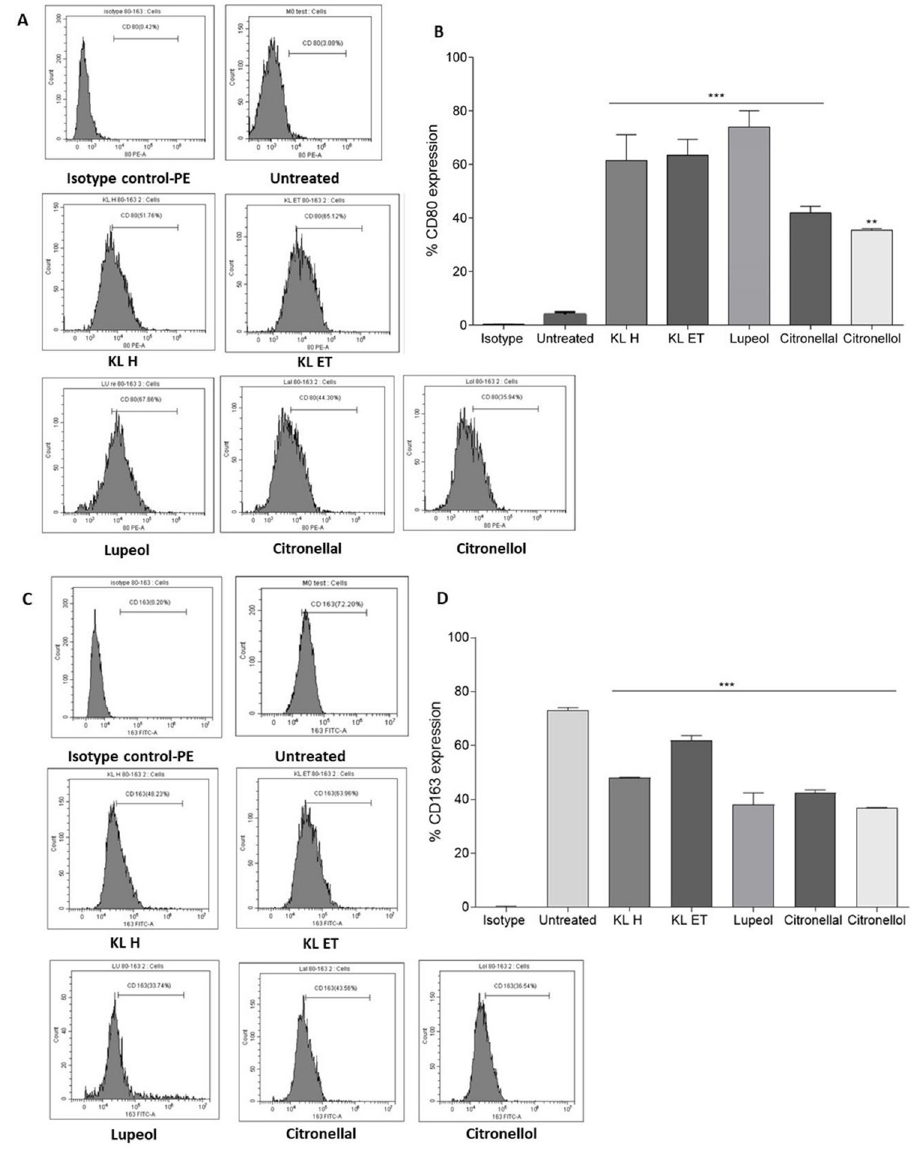
Fig 8. Characterization of the phenotype of THP-1 derived macrophages after treatment with crude KL extracts and their compounds. (A) and (B) Flow cytometry analyses of M1-typical surface markers representing the percentage of CD80 positive cells. (C) and (D) Expression of CD163 and M2 positive cells. Bar graphs are shown as means ± SEM., ��� p � 0.001, compared to the control. compound-mediated apoptosis in SCC15 significantly increased the level of pro-apoptotic (Bax) and cleaved-caspase 3 and suppressed the expression of Bcl-2 as anti-apoptotic. Anucha- preeda et al . suggested that the cell cycle of K562 (chronic myelocytic leukemia) was signifi- cantly arrested at the G2/M phase after treatment with a subfraction of kaffir lime leaves for 24 hours [27]. In this study, our findings were confirmed in a different cancer cell line. Crude KL extracts and their compounds (lupeol, citronellal and citronellol) inhibited tumor growth by induction of cell cycle arrest at G2/M phase and cell apoptosis in SCC15 same as a positive control drug, cisplatin. Cisplatin is one of the chemotherapeutic agents for treating the head